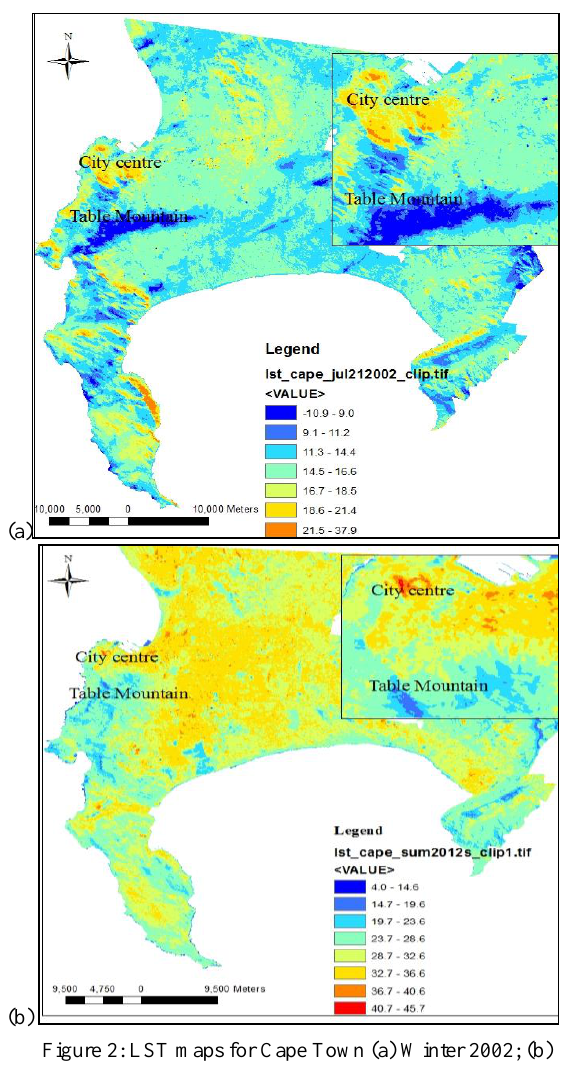
Figure 2: LST maps for Cape Town (a) Winter 2002; (b) Summer 2012